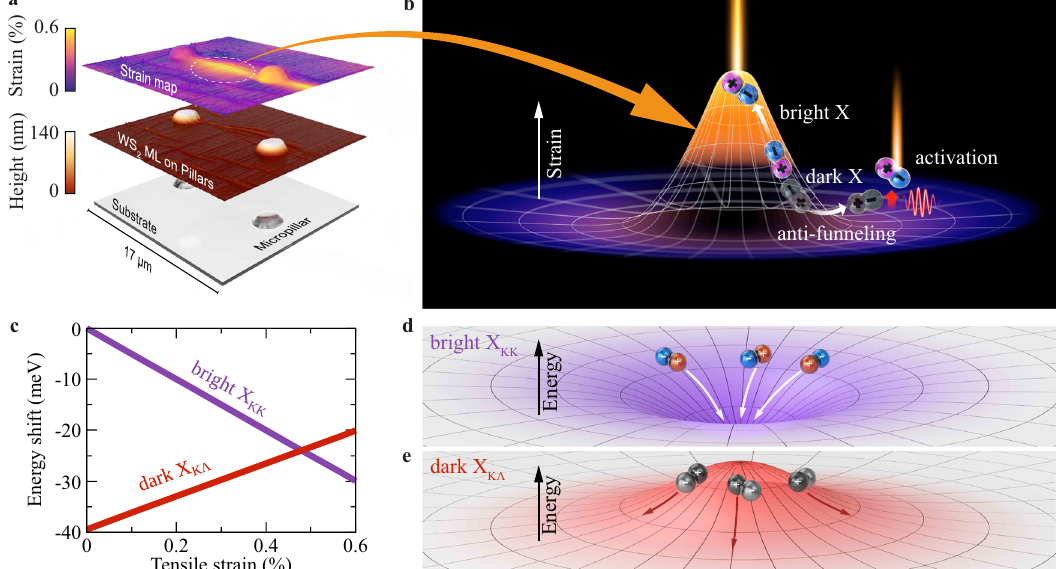
Fig. 1 Dark and bright exciton funneling in an atomically thin semiconductor. a Creation of an inhomogeneous strain pro fi le in a WS 2 monolayer via transfer on an array of polymer micropillars. The lowest graph shows the patterened substrate, the middle one the sample topography with the WS 2 monolayer, and the top one the resulting strain pro fi le in the experiment. b Illustration of funneling of bright excitons and anti-funneling of dark excitons in the strained material. Dark excitons can be activated by phonons and/or defects making them visible in optical spectra. c Strain-induced shift of dark X K Λ and bright X KK exciton resonances. d,e Opposite shifts of X K Λ and X KK give rise to reverse spatial energy gradients resulting in an unconventional anti- funneling of dark X K Λ excitons away from regions with maximum